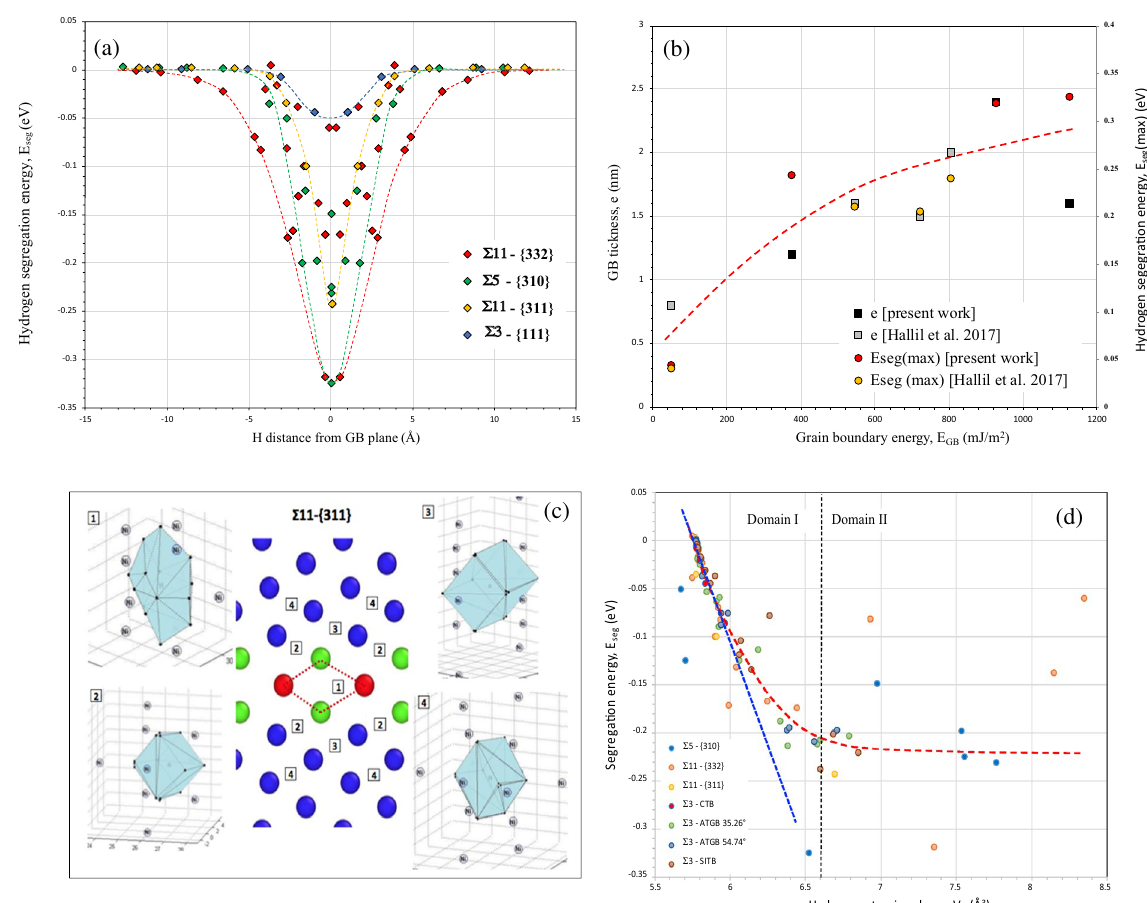
Figure 3. ( a ) Hydrogen segregation energy, E seg as a function of the hydrogen location in the grain boundary core region. ( b ) Grain boundary thickness, e and maximum hydrogen segregation energy, E seg (max) vs the grain boundary energy E GB . ( c ) Segregation position of hydrogen in GB Σ 11-{311} and their volume geometry defined by Voronoi’s method. ( d ) Segregation energy as a function of the hydrogen atomic volume V H for the different locations in the seven grain boundaries Fig. 3d. For low hydrogen atom energy, a linear relation with segregation energy is clearly established (E seg = 0.54 × E H + 0.0864) which corresponds to a range of low hydrogen atomic volume range V H < 6.6